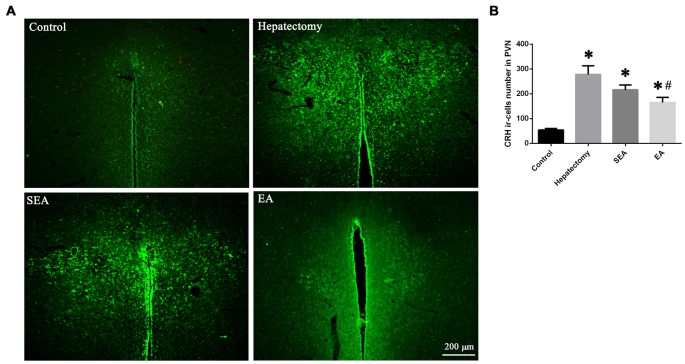
CRH-positive cells in the hypothalamic paraventricular nucleus (PVN). Immunofluorescent assay (A) and quantification (B) for CRH-positive cells in the hypothalamic PVN among the control, hepatectomy, SEA and EA groups. The data are presented as the mean ± SD (n = 5, scale bar = 200 μm) *vs. control group (p < 0.05); #vs. hepatectomy group (p < 0.05).